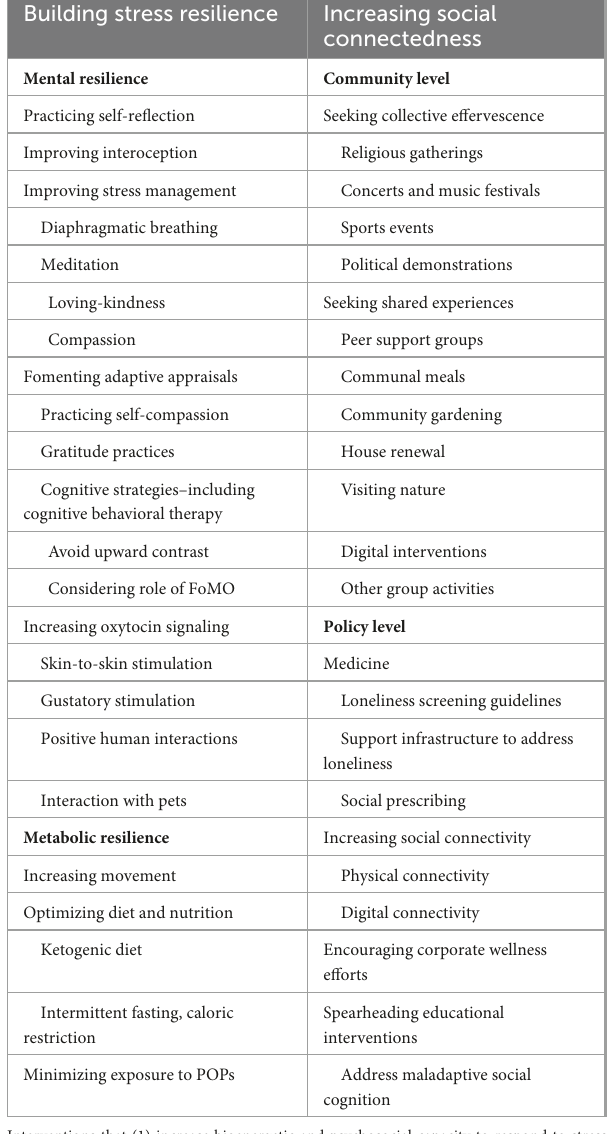
TABLE 1 Interventions for treating and preventing